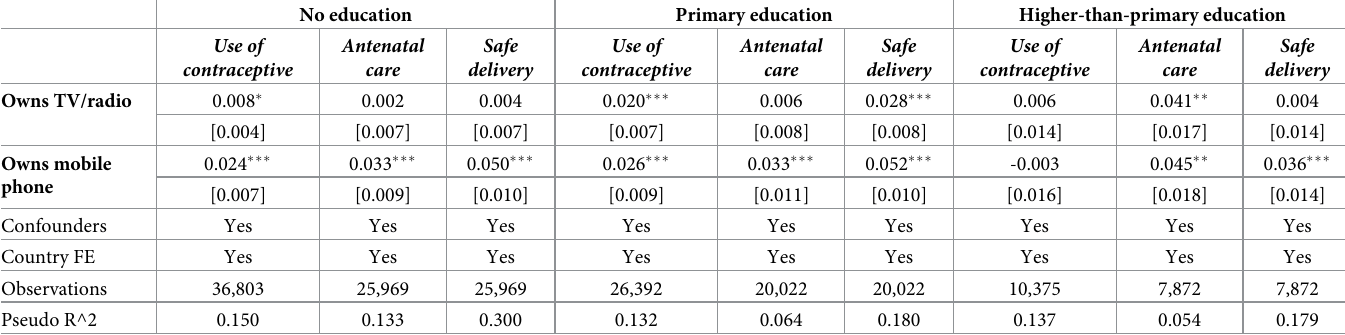
Table 3. Estimated marginal effects of communication technology on reproductive health by educational